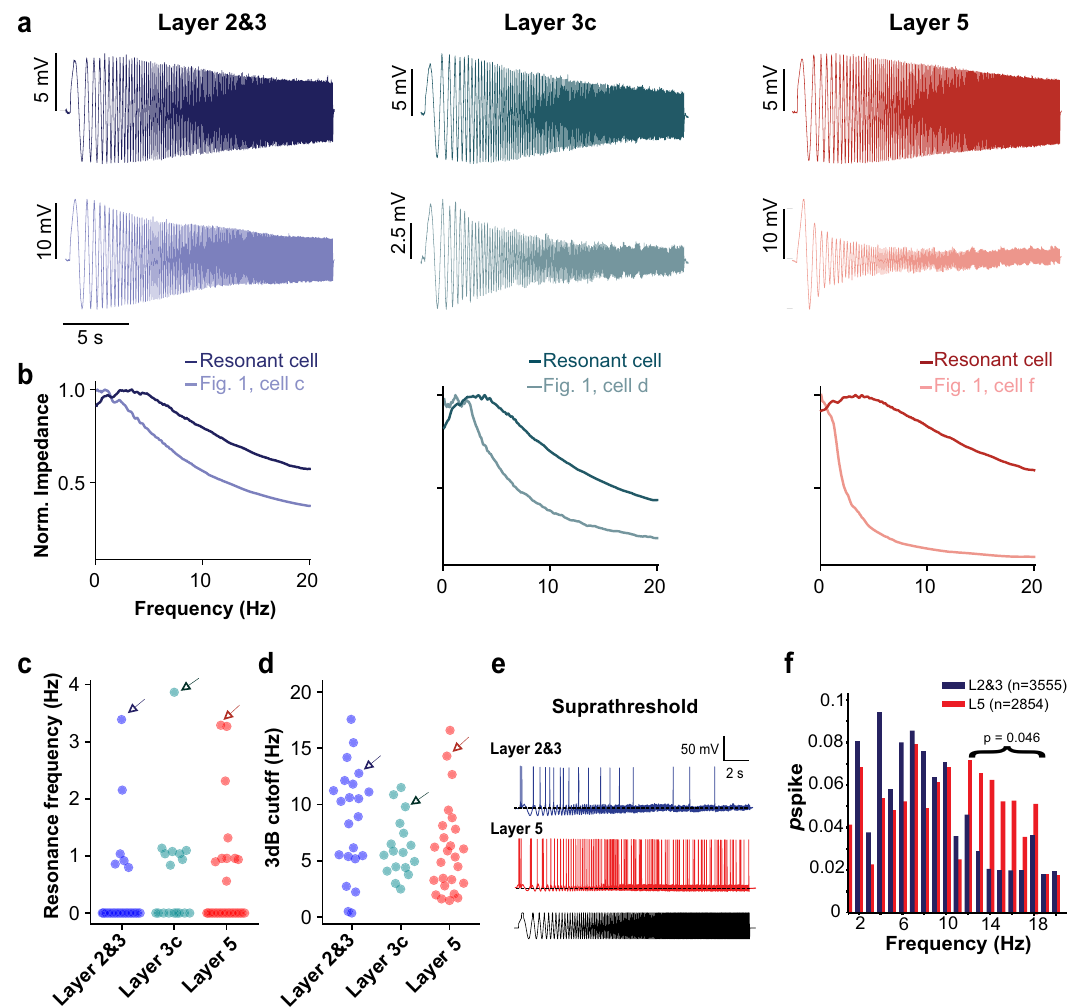
Fig. 4 Subthreshold and suprathreshold resonance properties of L2&3, L3c, and L5 pyramidal cells. a Example of voltage responses following injection of subthreshold frequency-modulated (ZAP) current delivered at resting membrane potential in L2&3, L3c, and L5 pyramidal cells. Voltage traces are averaged across fi ve repeated trials. Top voltage trace indicates response of a cell displaying subthreshold resonance and bottom trace corresponds to example cell morphologies shown in Fig. 1. Cell labels are provided below in b . b Normalized impedance pro fi les for the voltage traces shown in a , with impedances normalized to a maximum value of one. c , d Resonance frequencies ( c ) and 3 dB cutoff frequencies ( d ) indicate that there are relatively few strongly resonant pyramidal cells in our dataset. Arrows in c , d correspond to resonant cells highlighted in a , b . n = 23, 17, and 25 cells in L2&3, L3c, and L5, respectively. e Example voltage responses following injection of suprathreshold ZAP current. f Spike response probability in response to suprathreshold current injection shows that L2&3 and L5 pyramidal cells track theta frequencies with greater reliability. The distributions were not signi fi cantly different (KS p = 0.530). Above 12 Hz, spike probabilities differed signi fi cantly between L2&3 and L5 ( p = 0.046; two-sample Kolmogorov – Smirnov, L2&3 n = 27, L5 n = 30). Source data are provided as a Source data fi